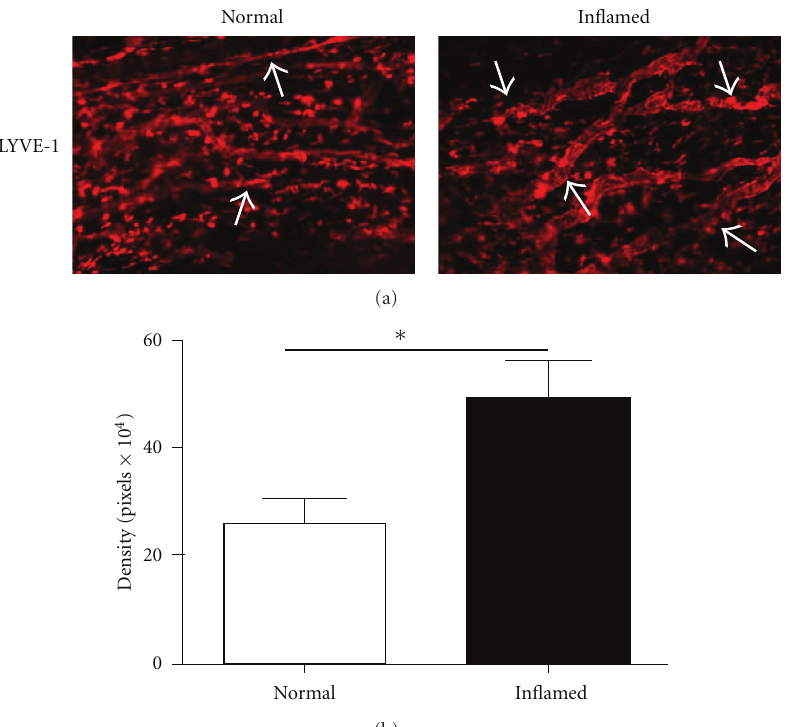
Figure 3: Comparison of lymphatic distribution in the conjunctiva between normal and inflamed conditions. (a) Representative immunofluorescent micrographs illustrating more lymphatic vessels in the conjunctiva of suture-induced inflamed cornea. LYVE-1: red. Original magnification: × 50. (b) Summary of repetitive experiments. ∗ P < 0 . 05.